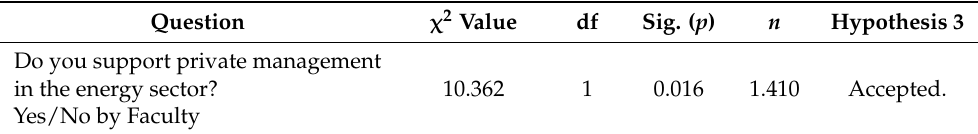
Table 4. Chi-Square Test results for FER students regarding support of PPP in the energy sector. Question χ 2 Value df Sig. ( p